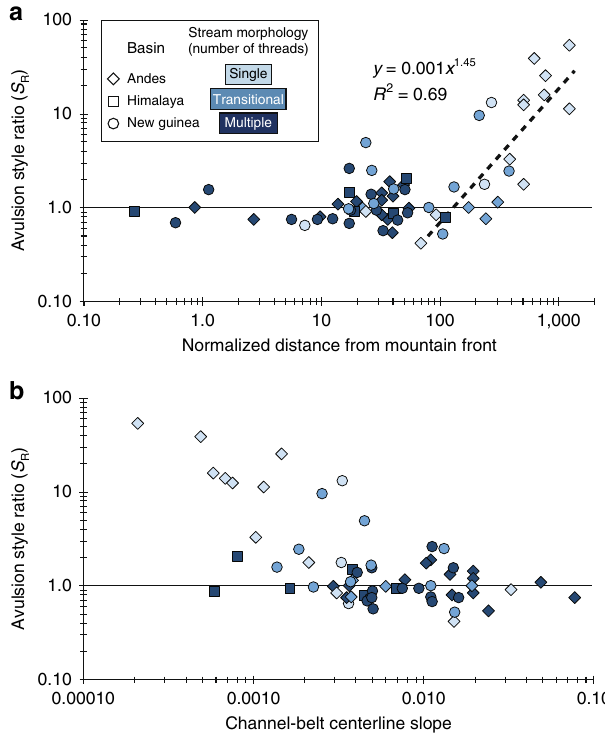
Fig. 3 Avulsion style depends on downstream distance and slope. a Avulsion style ratio ( S R ) is positively correlated with the normalized distance from the mountain front (distance/channel width). For distances < ~60, S R ranges between ~ 0.5 and 2.5, except for one outlier with S R 4.9. These low S R values indicate annexation-dominated avulsion. Beyond a normalized distance of ~60 – 100, S R exhibits a strong positive correlation with distance. These higher S R values indicate avulsions with signi fi cant progradation. Only samples with x -axis values >60 were used to calculate the best fi t line. b S R is negatively correlated to river slope. On slopes steeper than ~0.005, S R is small and ranges from ~0.5 to 2.5. On slopes shallower than 0.005, S R increases as slope decreases.